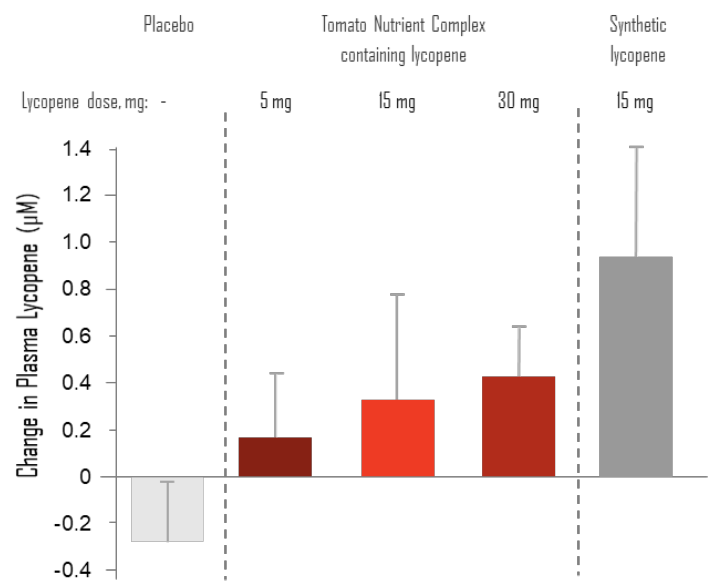
Figure 3. Changes of plasma levels of lycopene from baseline to eight weeks. Results are the mean ± SD of the changes from baseline to Week 8 within treatment arms. N was 9, 7, 7, 9, and 7 for the placebo, TNC 5 mg, TNC 15 mg, TNC 30 mg and synthetic lycopene arms,